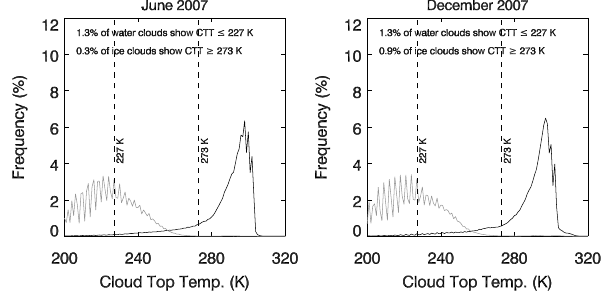
Fig. 3. Frequency distributions of MODIS-derived CTT for water (black solid line) and ice (grey solid line) clouds at a 5-km reso- lution for June 2007 (left panel) and December 2007 (right panel) over 100 ◦ E–180 ◦ E, 40 ◦ N–40 ◦ S